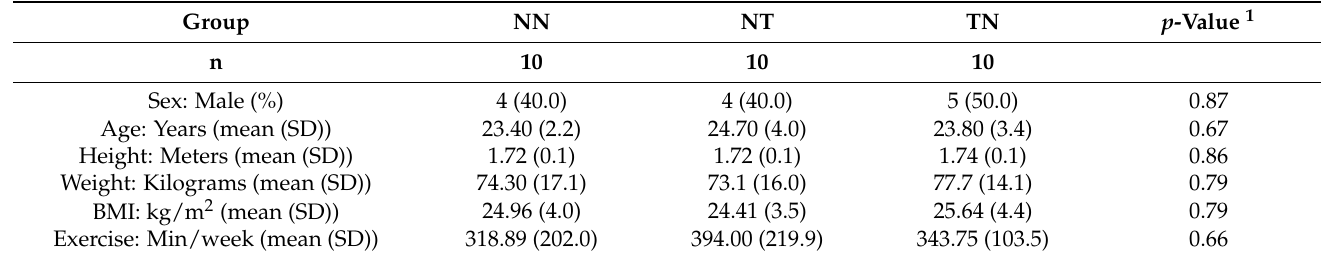
Table 1. The group demographics and